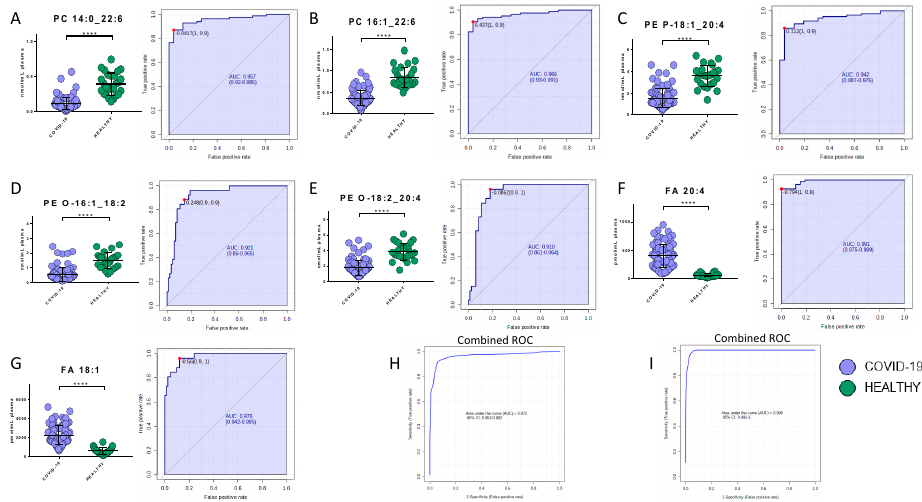
Figure 6. Bar plots (average ± SD) with relative statistical significance ( p -value < 0.0001 = ****) and ROC curves with the optimal cutoff calculated for each ROC analysis (red dot) are reported in order to show the best potential biomarkers identified using lipidomics analysis. Phosphatidylcholine 14:0_22:6 ( A ), phosphatidylcholine 16:1_22:6 ( B ), phosphatidylethanolamine 18:1_20:4 ( C ), arachidonic acid ( D ), oleic acid ( E ), glycerophosphoethanolamines PE (O-18:2_20:4) ( F ), and glycerophosphoethanolamines PE (O-16:1_18:2) ( G ). Combined ROCs ( H , I ) are also shown. Gender is often considered an unimportant variable in the evaluation of biomarkers of human disease; however, it is now clear that the severity of SARS-CoV-2 infection might be correlated with gender. Therefore, we explored whether metabolomics and lipidomics profiles were linked with gender; the PCA (Figure S10A–C) indicated that male and female patients were well distributed across all samples and that clusters specifically related to males or females were not present.